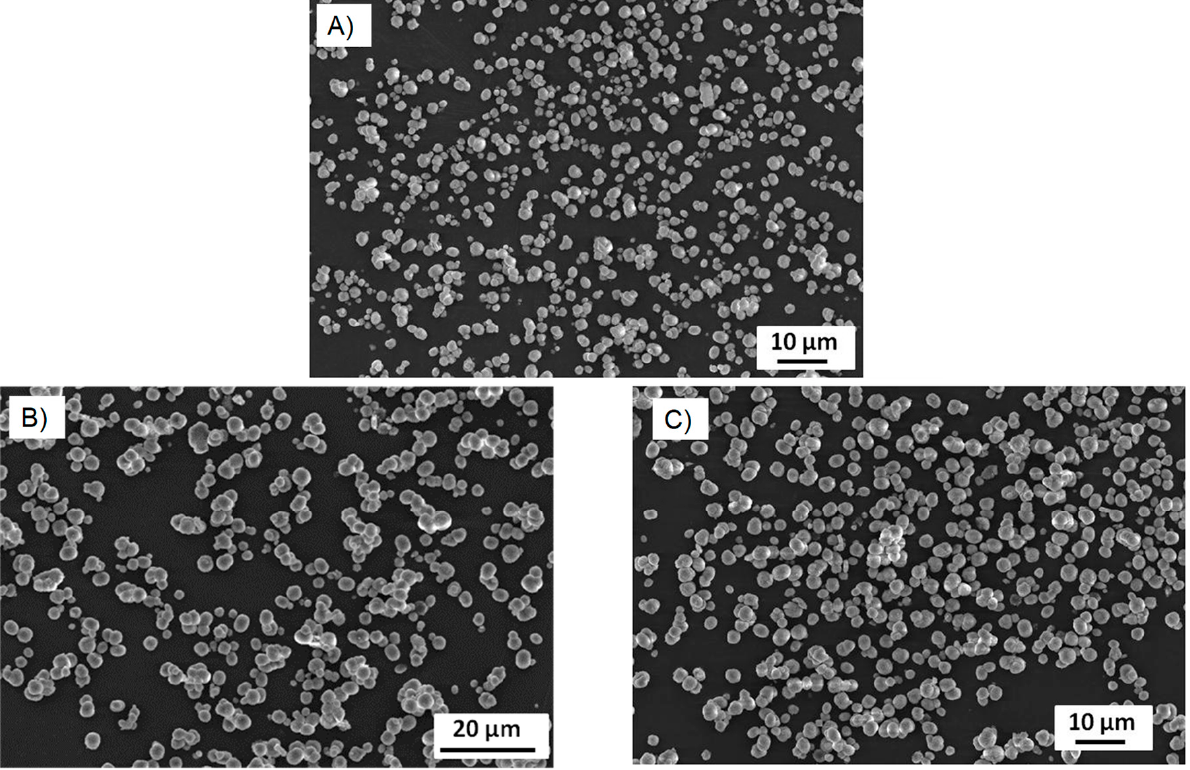
Figure 6. Scanning electron microscopy image ( A ) CD-PVSA_30mM_10min, ( B ) CD-PVSA_5mM_4h and ( C )